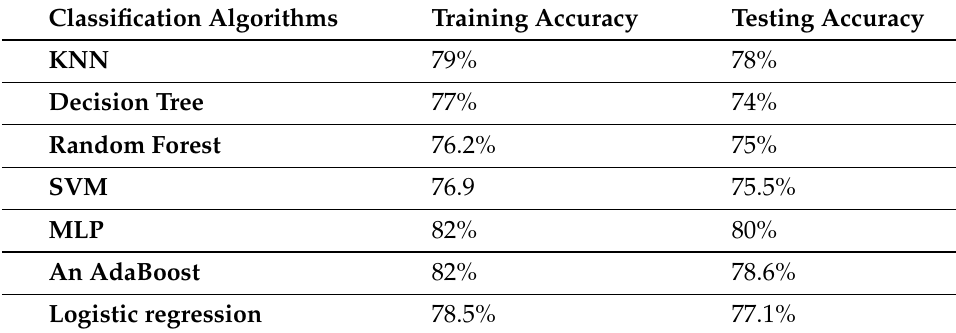
Figure 11. The final result for classification algorithms accuracy. Table 4. The final result for classification algorithms